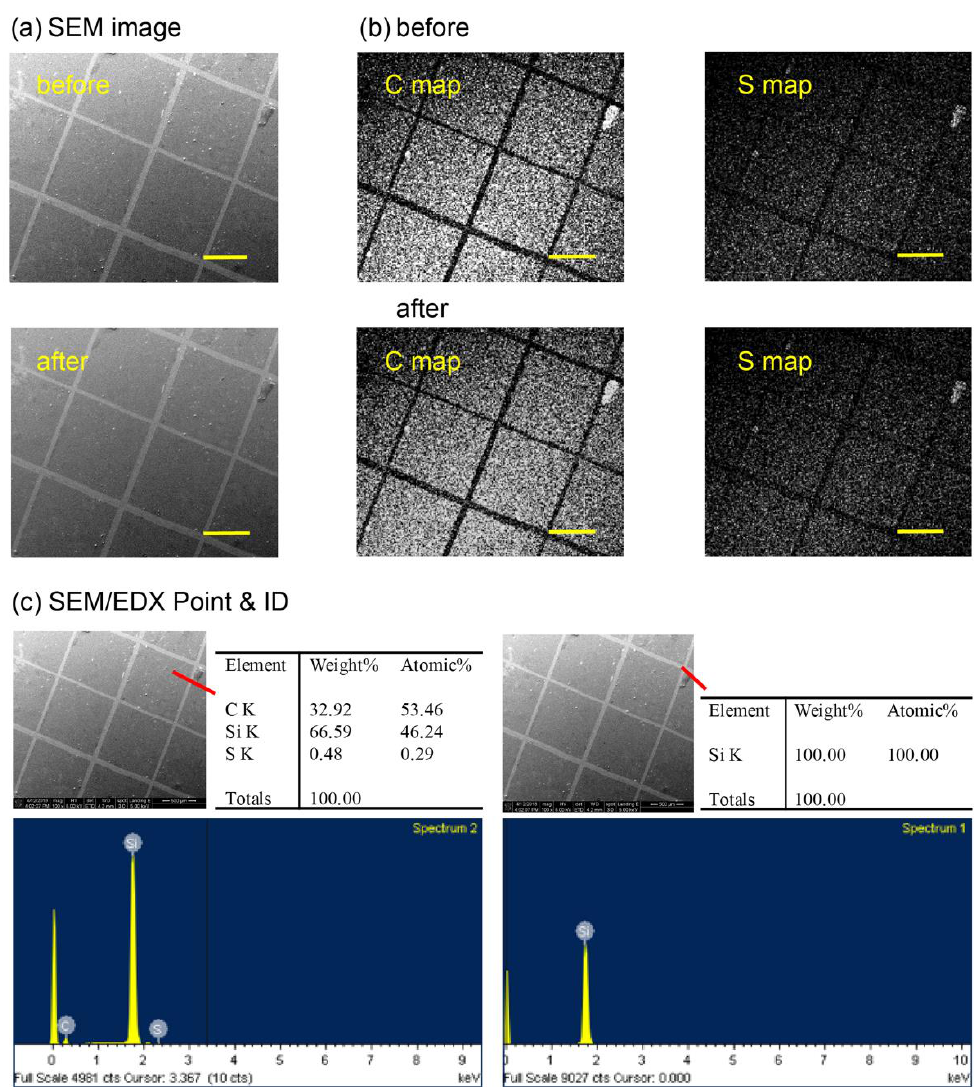
Figure 1. The mechanical adhesion of the erasable coating on the substrates was examined via an adhesion test. ( a ) Scanning electron microscope (SEM) images of the erasable coating before and after the cross-cut tape adhesion test. ( b ) SEM/energy dispersive X-ray analysis (EDX) elemental maps of carbon (C) and sulfur (S) showed no apparent damage after the adhesion test compared with those before the test. ( c ) SEM/EDX Point and ID precisely indicated carbon (C), sulfur (S), and silicon (Si) on the intact regions (square-shaped areas), whereas only Si was detected on the bare substrate. Scale bars: 600 μm.